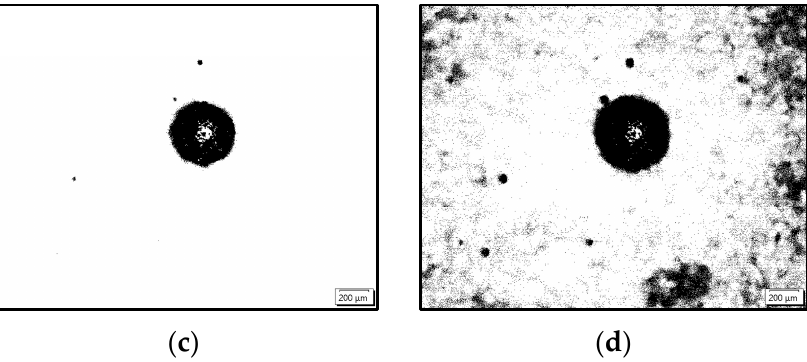
Figure 4. Binarized image: ( a ) Origin image; ( b ) threshold = 90 ; ( c ) threshold = 110; ( d ) threshold = 130.